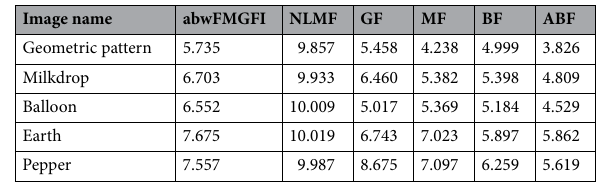
Table 7. Comparison of the RMSE values of each sample image filtered using each filter (against the Gaussian noise).